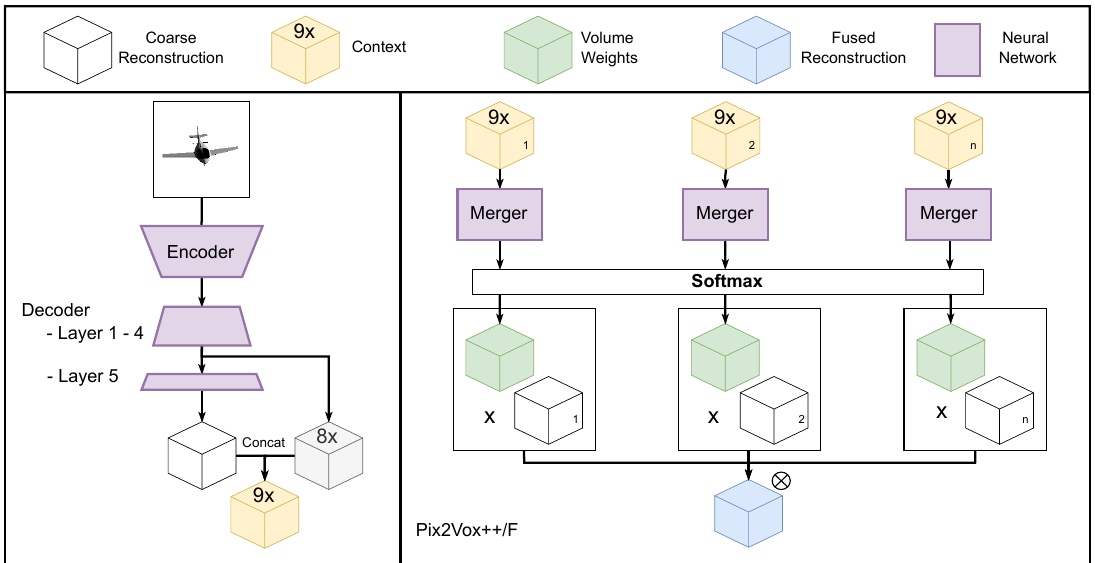
Figure 2. In the original Pix2Vox++/F architecture, the merger receives a context tensor for each input image and produces a single fused reconstruction. To maintain sufficient detail, this context tensor is a concatenation of the feature maps outputted by the 4th layer of the decoder and the coarse 3D reconstruction outputted by the final layer of the decoder.